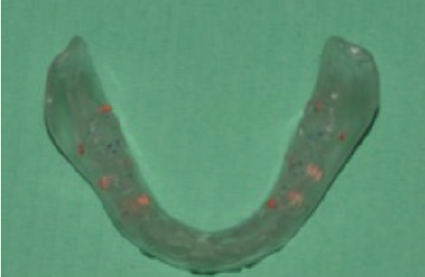
Figure 3: The low denture duplicated and with the gutta-percha markers to be used for the